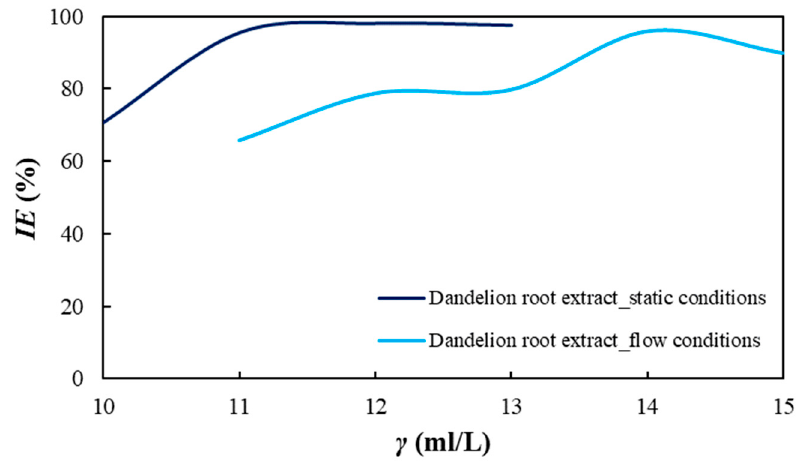
Figure 10. The inhibitor efficiency comparison determined from EIS scanned on the carbon-steel sample in the simulated brine saturated with CO 2 (Adapted from [24]).